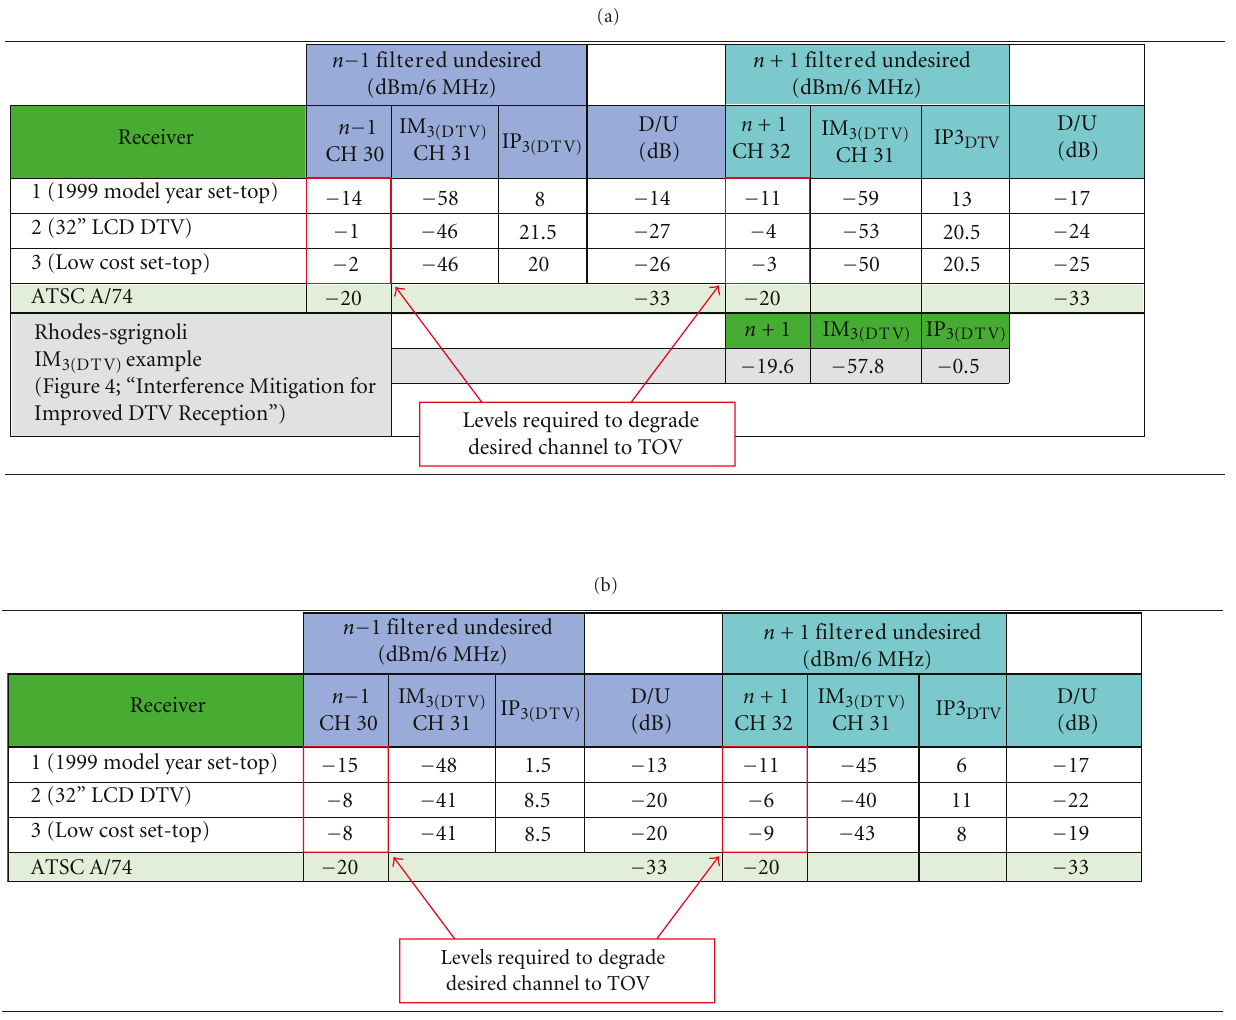
Table 4: (a) Desired channel power = − 28dBm/6MHz; minimum undesired signal IM 3(DTV-T) ; (b) desired channel power =